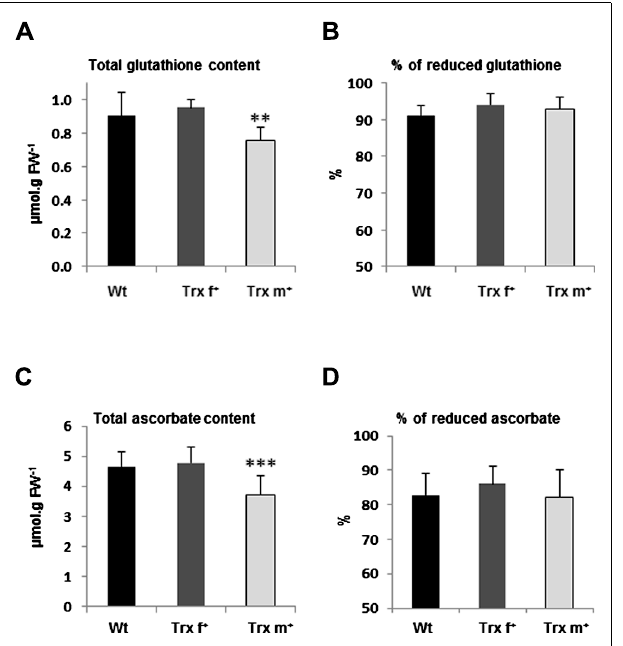
FIGURE 6 |Tolerance to photooxidative treatment of transplastomic tobacco plants overexpressingTrx f orTrx m. Photooxidative treatment was carried out by exposing 30-old tobacco plants grown in standard conditions to high light intensity (950 μ mol photons m − 2 s − 1 ) and low temperature (8 ◦ C) under a 12-h photoperiod in a controlled growth chamber. (A) Photograph showing representative plants subjected to the treatment for 5 days.Three independent experiments were carried out with three plants per genotype in each experiment. (B) Maximal photosystem II photochemical efficiency in tobacco plants. F v / F m values were measured in plants grown in control conditions for 32 days (full bars) and in plants further subjected to photooxidative conditions for 5 days (dashed bars). Data are mean values ± SD of the average values from eight measurements performed on five plants per genotype. Measurements were performed on representative areas from three leaves (indicated by arrows in panel A ) per plant.Wt, wild-type;Trx f + andTrx m + , plants overexpressingTrx f orTrx m, respectively.Values significantly